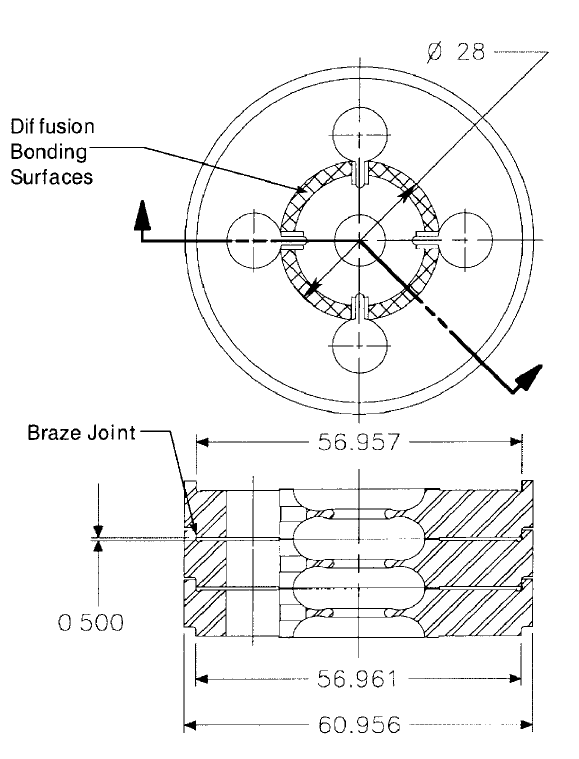
FIG. 16. Schematic illustration of the conceptual design.